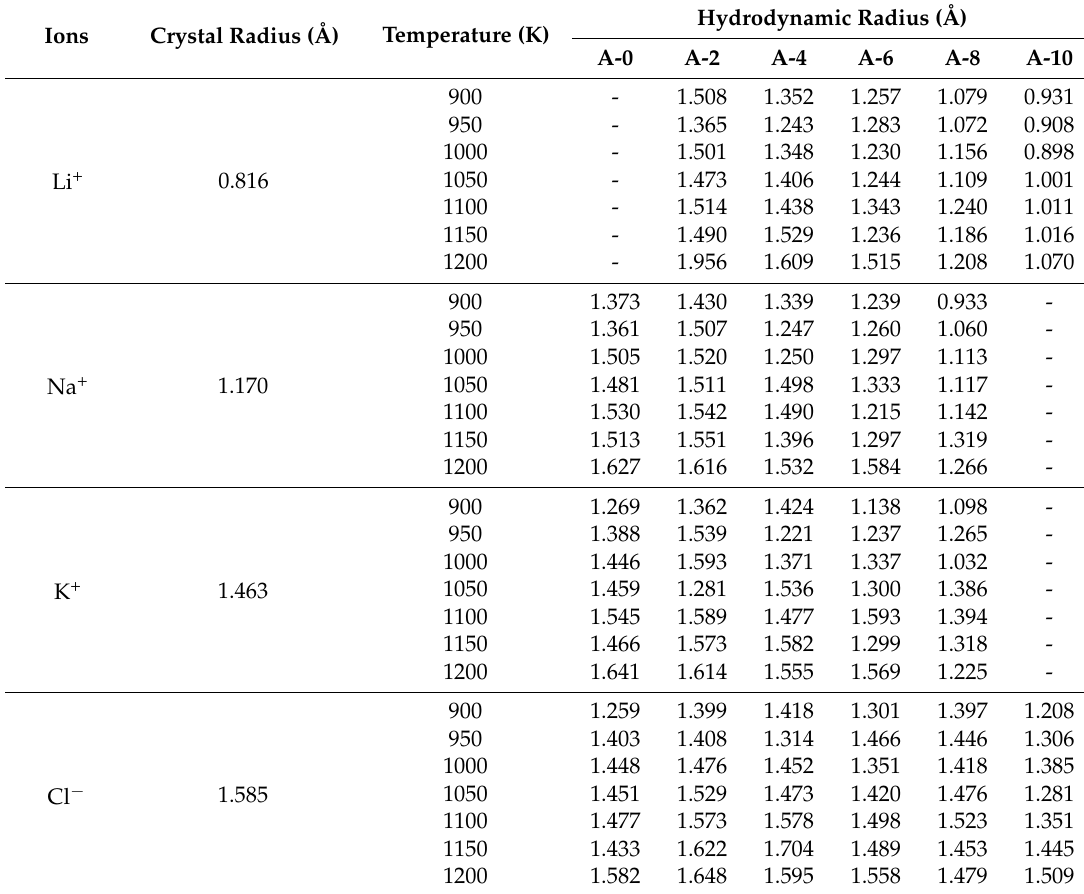
Table 6. Hydrodynamic radii of the ions in different systems at different temperatures. Ions Crystal Radius